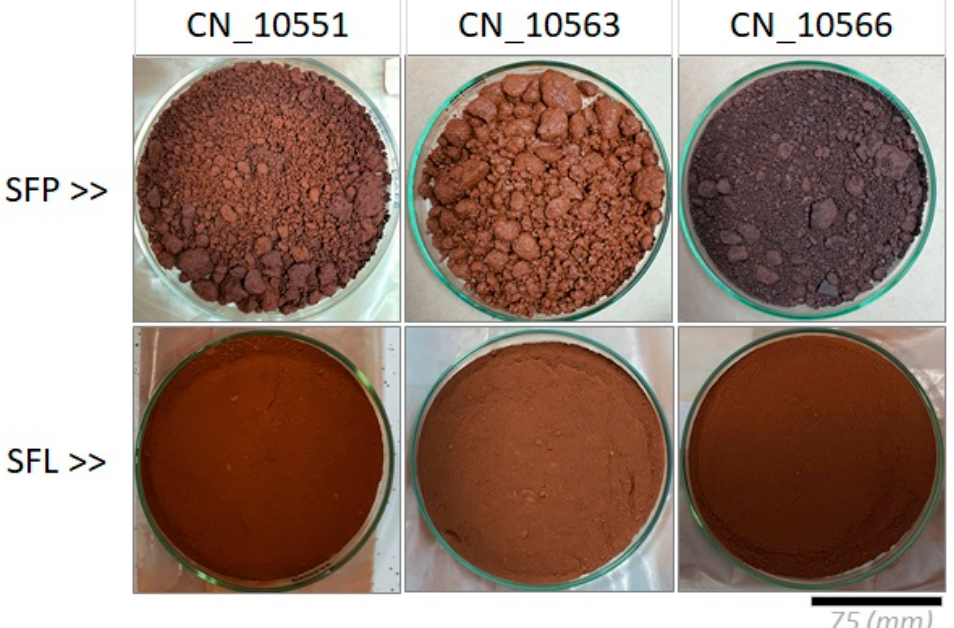
Figure 3. Photographs of the Sinter Feed product samples and their corresponding samples prepared in the laboratory.